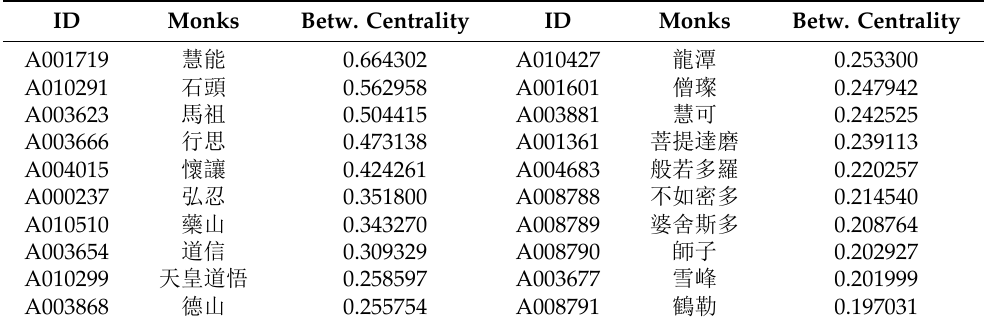
Table 2. Figures ranked by betweenness centrality in the ZTJ ’s genealogical network. Scope: 20